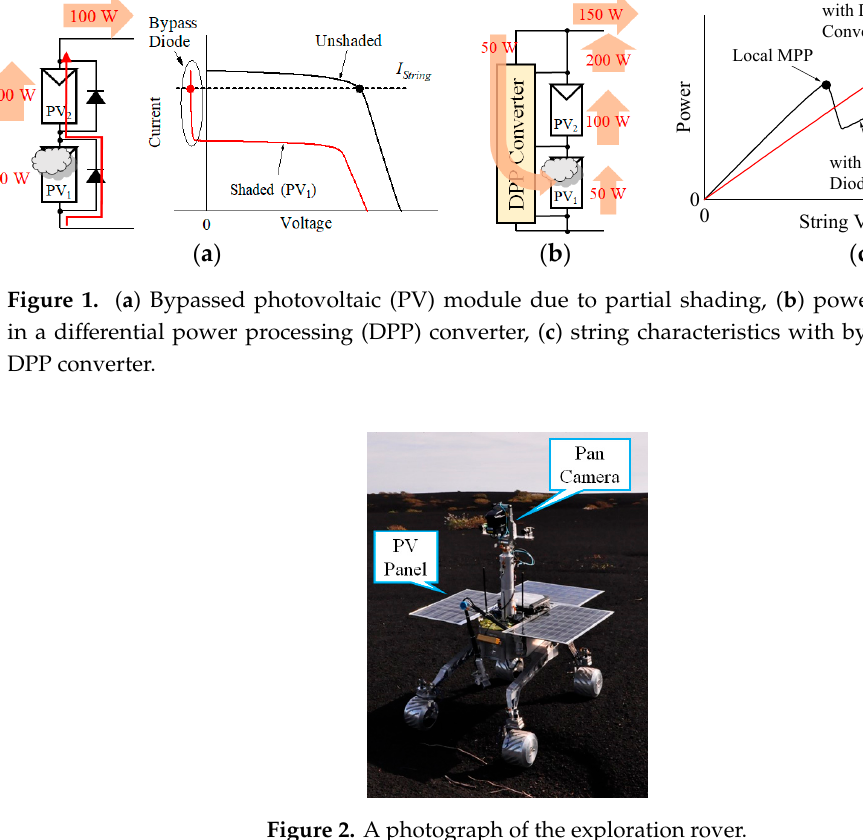
Figure 2. A photograph of the exploration rover.